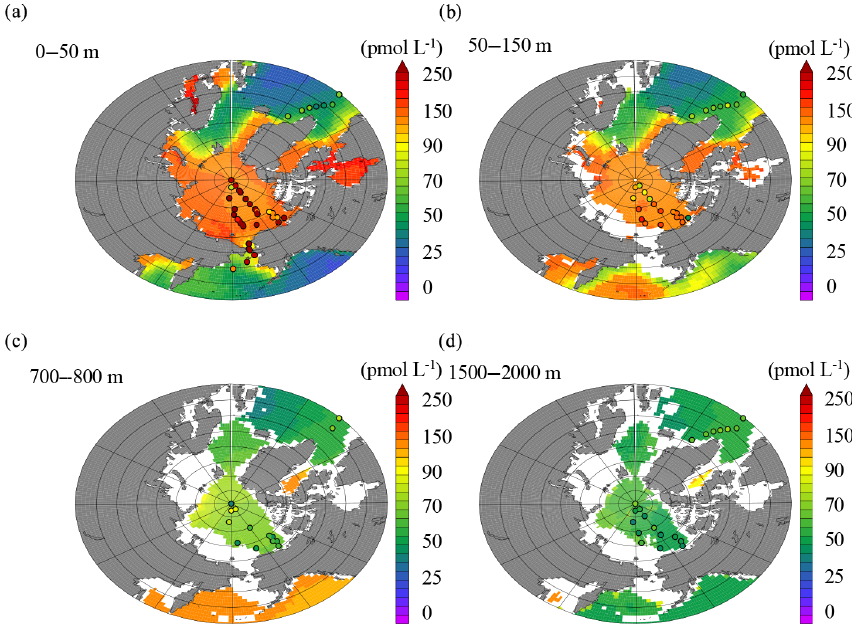
Figure 8. Model output (colors) compared to observations (dots) from 0 to 50m (a) , 50 to 150m (b) , 700 to 800m (c) , and 1500 to 2000m (d) .